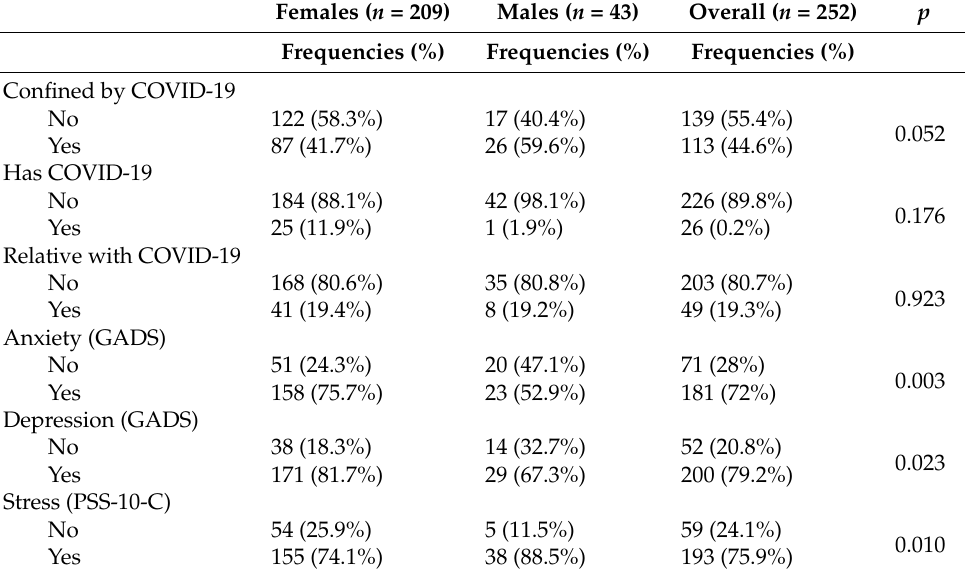
Table 5. Characteristics per gender in students’ well-being and health.